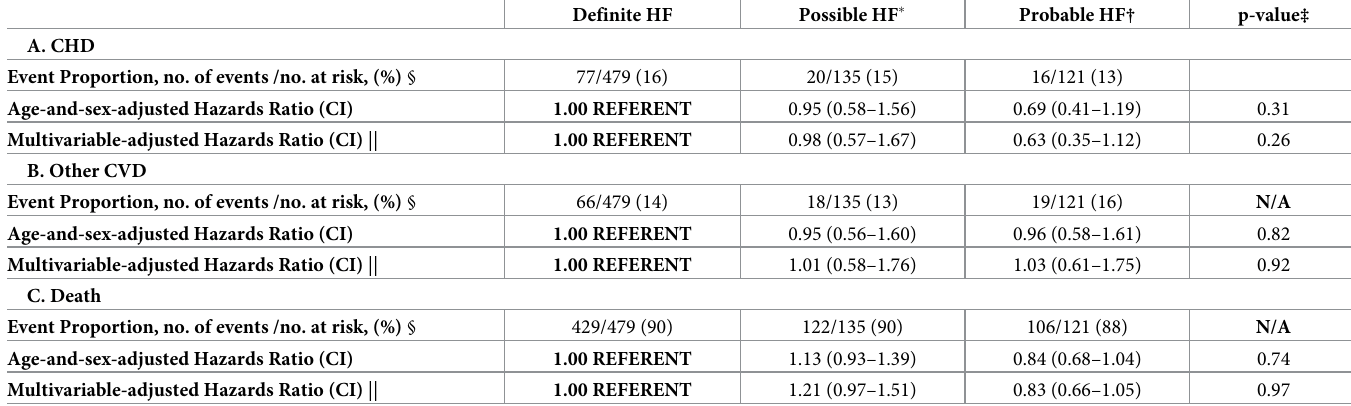
Table 4. Risk of various events in those with possible and probable HF, compared with definite